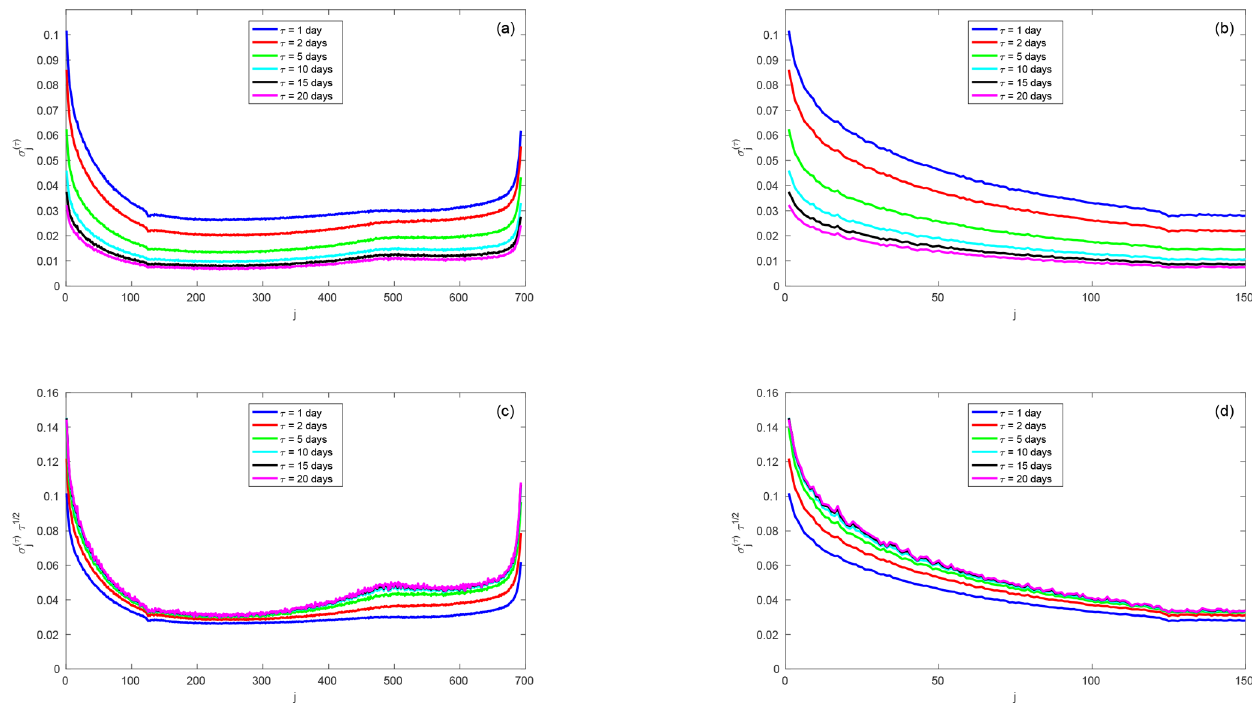
τ 1 / 2 of the FTLEs. (d) Close-up j